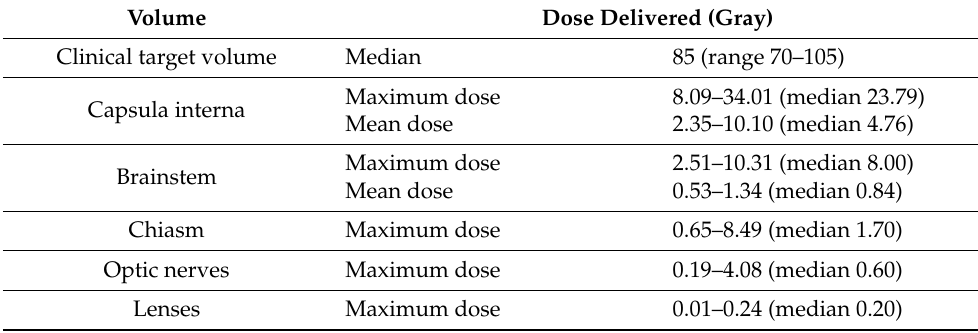
Table 3. Doses delivered to the target volume and nearby organs at risk.